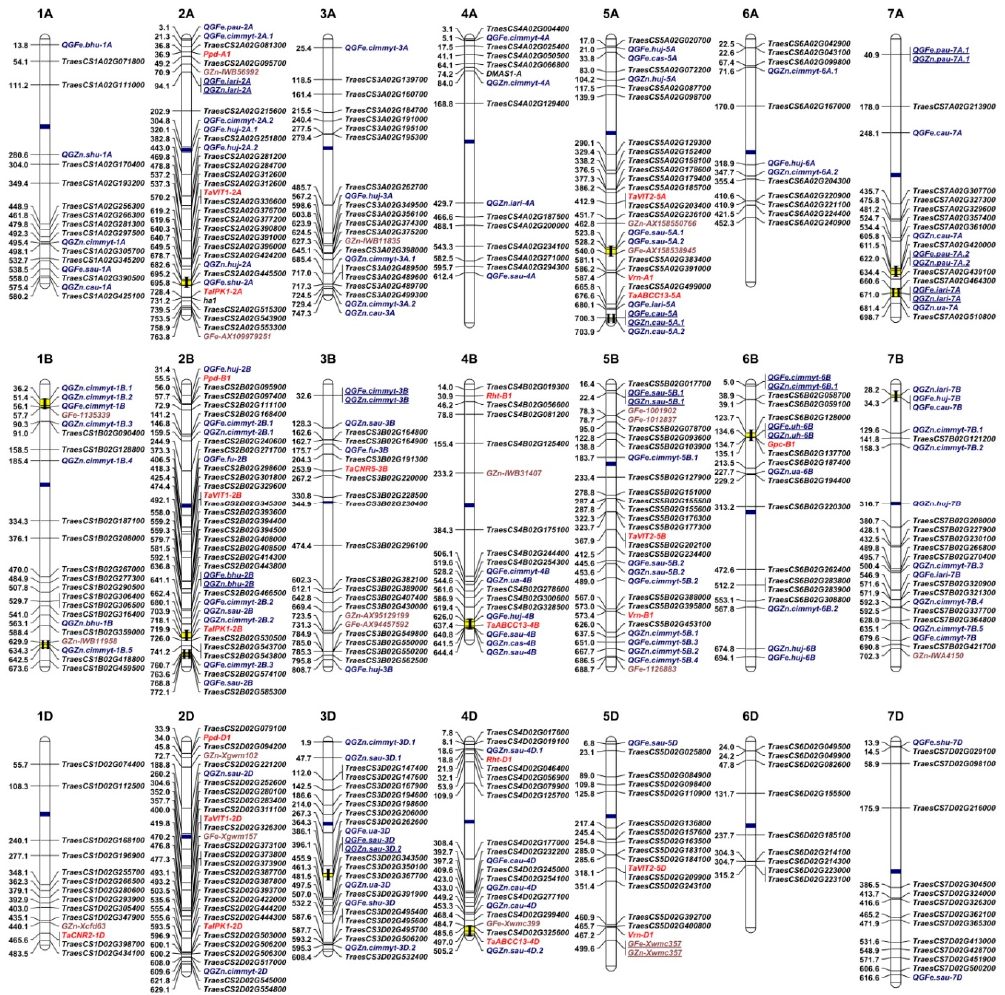
Figure 1. Landscape of genetic architecture underlying Fe- and Zn-related traits in wheat. 1A–7A , 1B–7B , and 1D–7D indicate the numbers of chromosomes in wheat. Genetic loci for Fe and Zn traits identified from wheat orthologs of Arabidopsis and rice genes, QTL mapping, association studies, and cloned wheat genes are displayed in black, blue, brown, and red, respectively. Blue and yellow bars within chromosomes indicate the locations of centromeres and QTL-rich clusters. “GFe” and “GZn” indicate grain Fe- and Zn-related loci, respectively. QTL associated with both Fe and Zn are underlined.